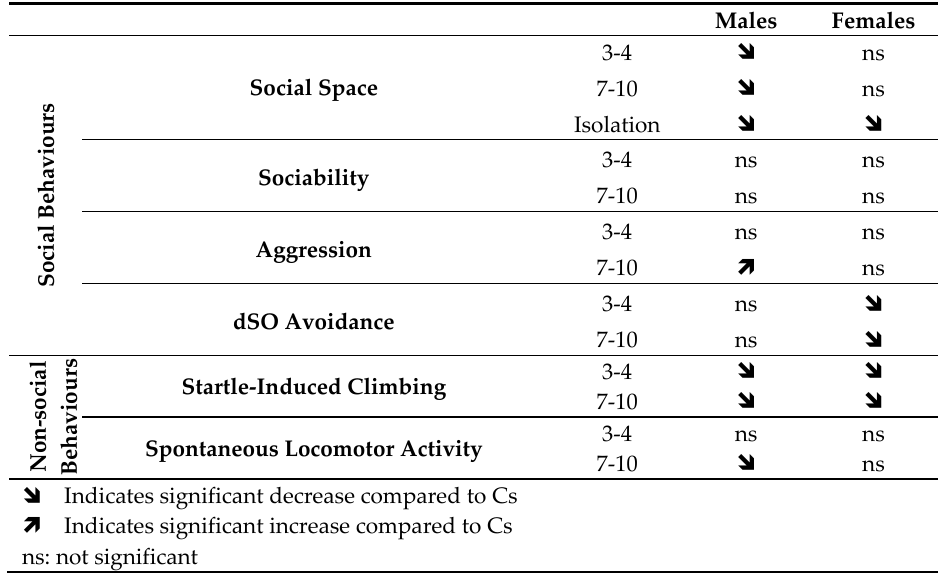
Table 1. Summary of behavior which performances significantly increased or decreased in nlg Def1 males and females compared to sex and age-matched Cs.